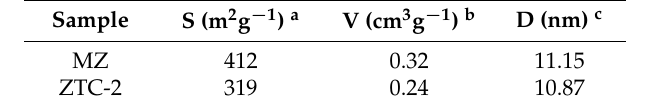
Table 5. Specific surface area (S), Pore volume (V) and Average pore diameter (D) for MZ and ZTC-2.